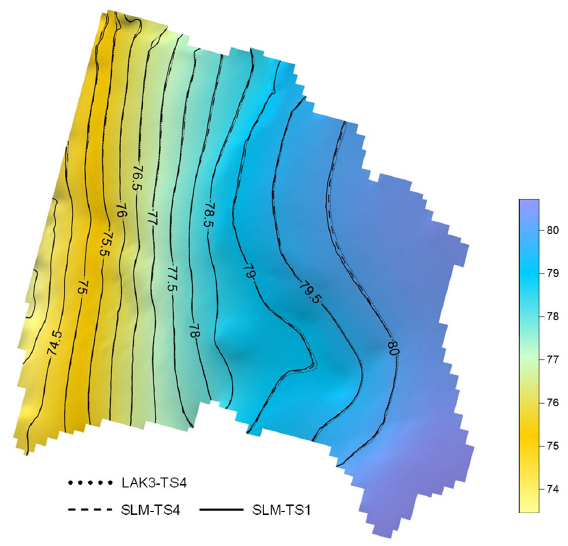
Figure 6. Spatial distribution and contour of simulated groundwater head in 2008.